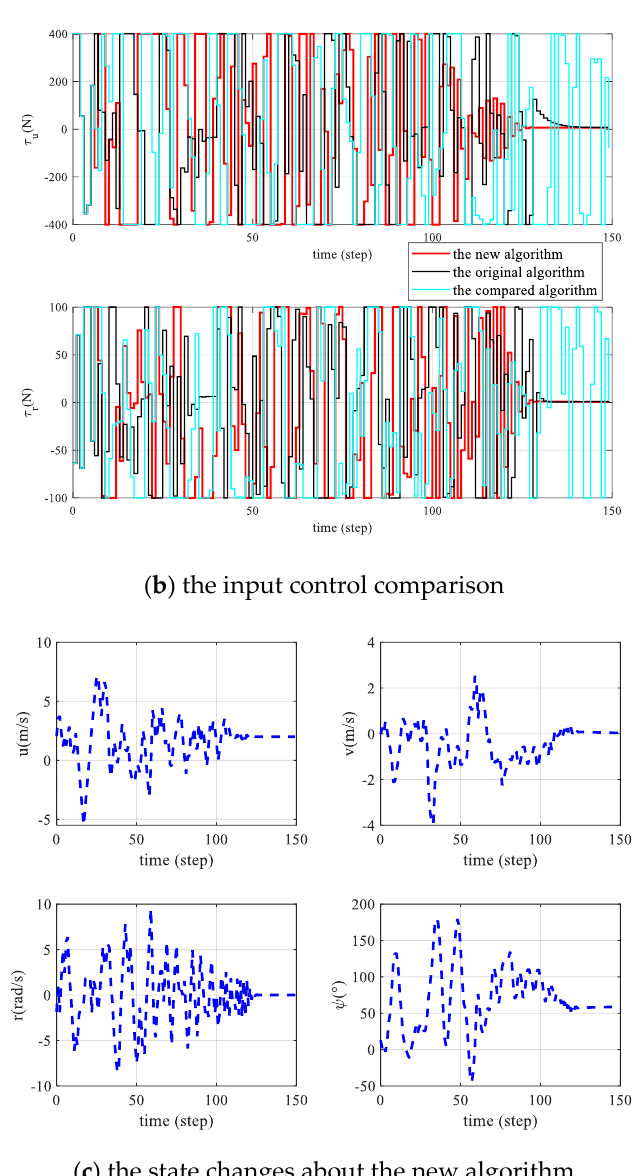
Figure 8. Comparison of algorithms under four obstacle ships.